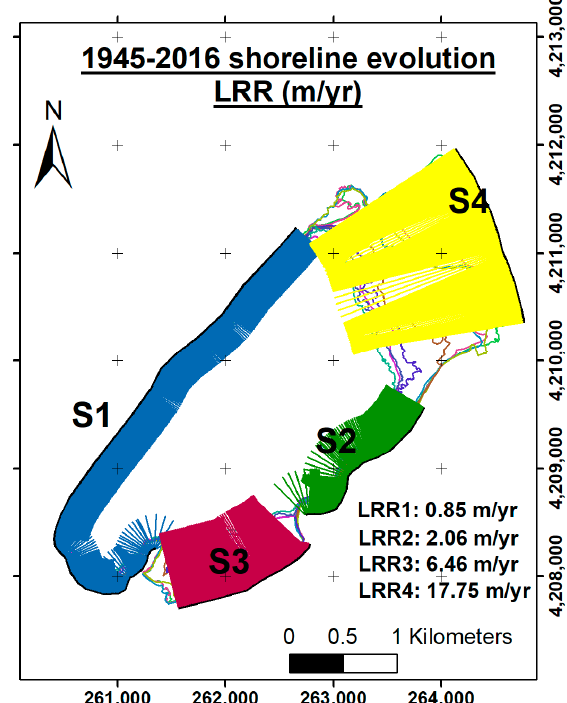
Figure 10. Kotychi Lagoon’s LRR shoreline change rates for the 1945–2016 period separated into four different sections of change.